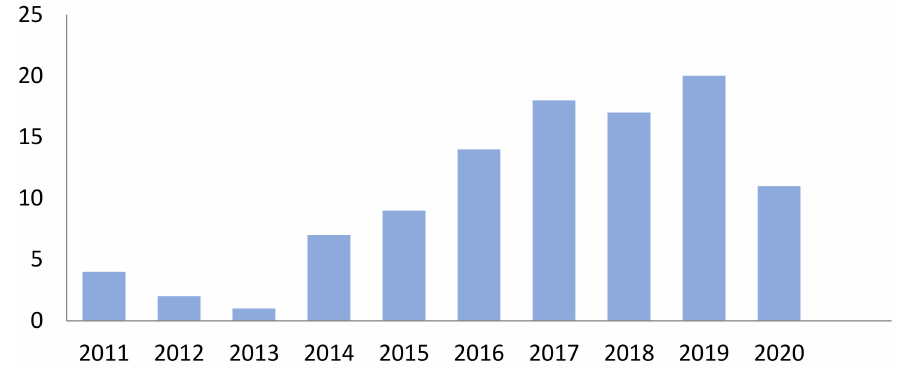
Figure 3. Number of papers selected over